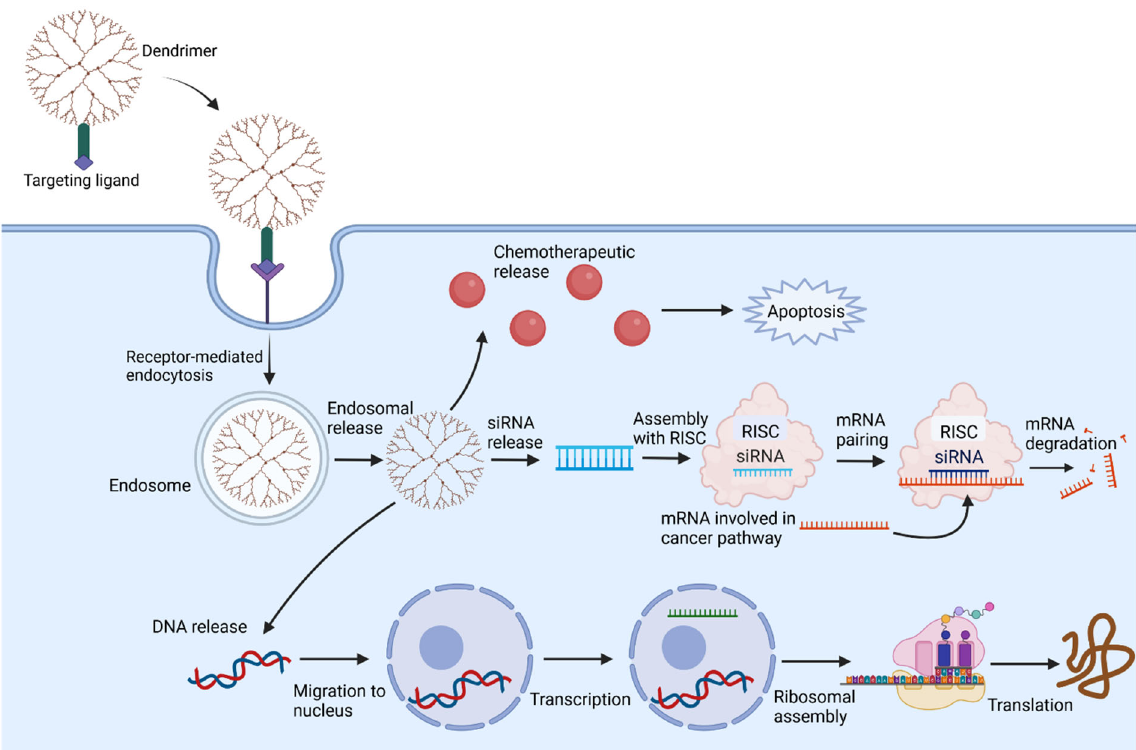
Figure 3. Dendrimers can enter the target tissue via several mechanisms, including receptor-mediated endocytosis, as depicted. Once inside, dendrimers can exert a variety of effects depending on their associated functional groups. Dendrimers can release chemotherapeutic drugs encapsulated within their core or conjugated to their surface to promote apoptosis of tumor cells. Alternative uses of dendrimers include release of genetic material. Release of siRNA can allow for selective degradation and inhibition of mRNA involved in tumor development, proliferation, and survival. Dendriplexes release DNA that travels to the nucleus and undergoes transcription and translation to produce proteins, a novel form of gene therapy.